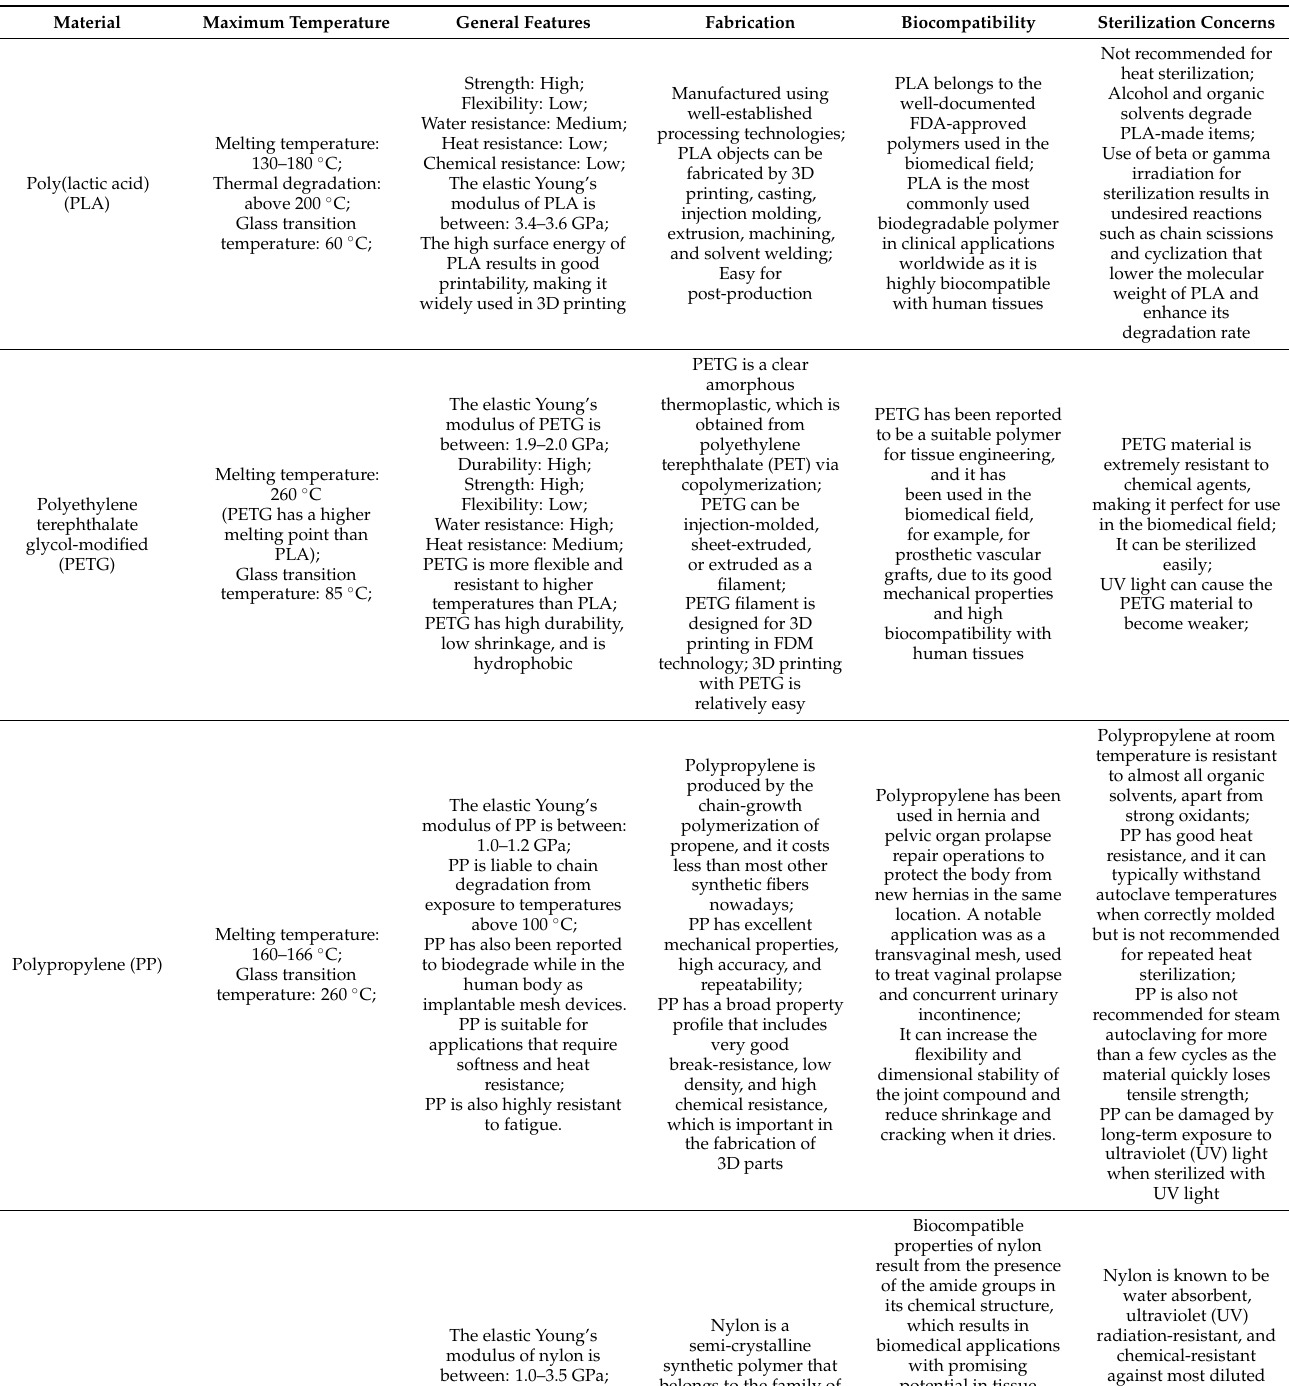
Table 2. Universal characteristics of selected 3D-printing materials used in this